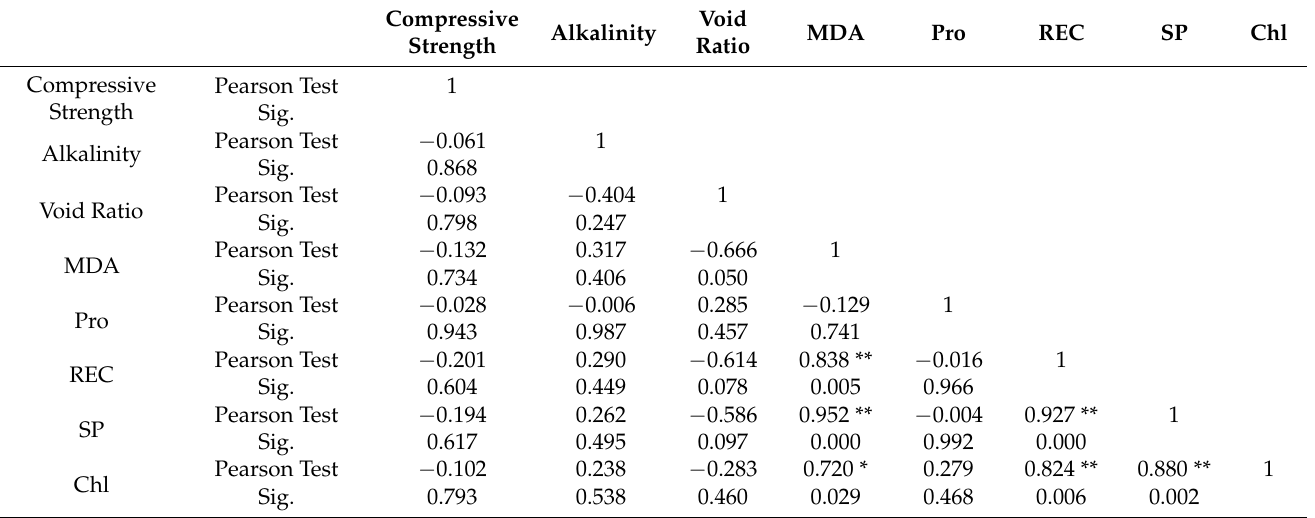
Table 6. Correlation coefficients between physical indexes and plant physiological indexes, n = 9 (Group